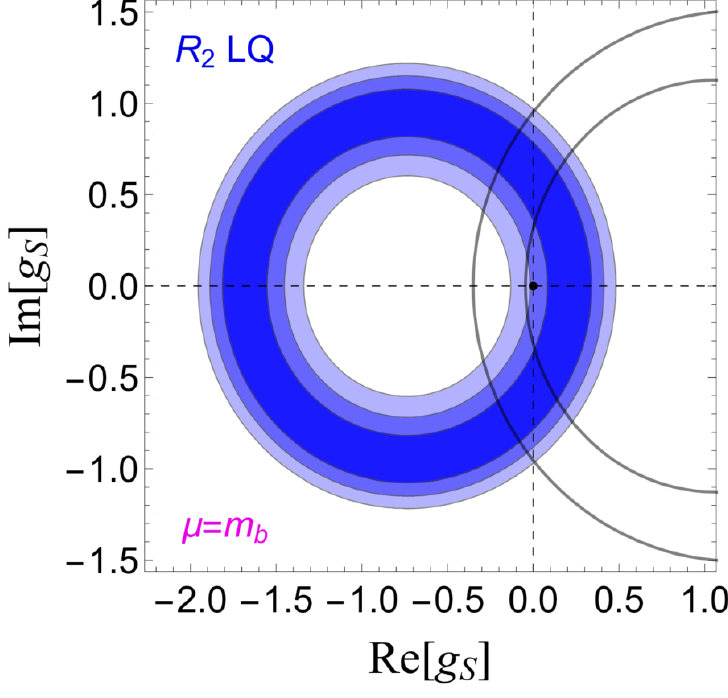
Figure 2 . Regions of allowed values for g S ( (cid:22) = m b ) on the complex plane, compatible with experimentally measured R D to 1 , 2 and 3 (cid:27) (from darker to lighter blue). We assumed g S ( (cid:22) = (cid:0) (cid:0) m (cid:1) ) = 4 g T ( (cid:22) = m (cid:1) ), as predicted by the R 2 LQ scenario, and considered the QCD running from (cid:2) (cid:22) 1 TeV to m b , cf. eq. (2.5). We also show in black the region compatible to 2 (cid:27) accuracy with (cid:25) R exp , which indicates that the e(cid:11)ective couplings must be complex in this scenario. See discussion D (cid:3) in the